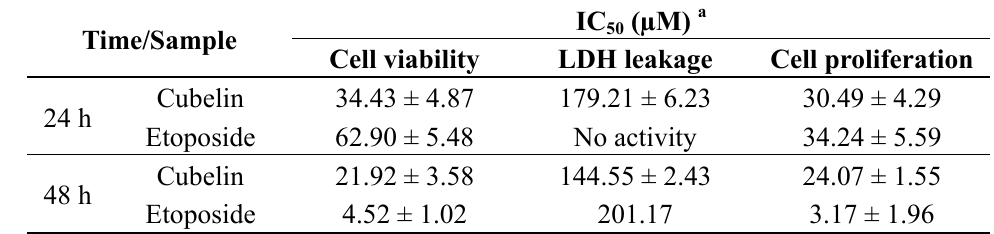
Table 2. Activity of cubelin and etoposide on HeLa cells viability, proliferation and LDH